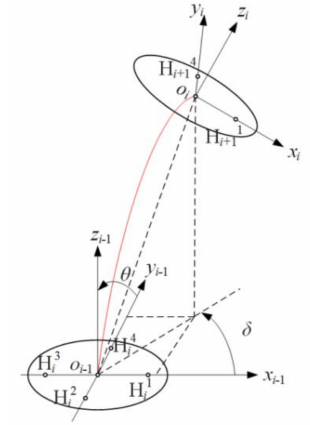
Figure 2. Kinematics model of a single segment.